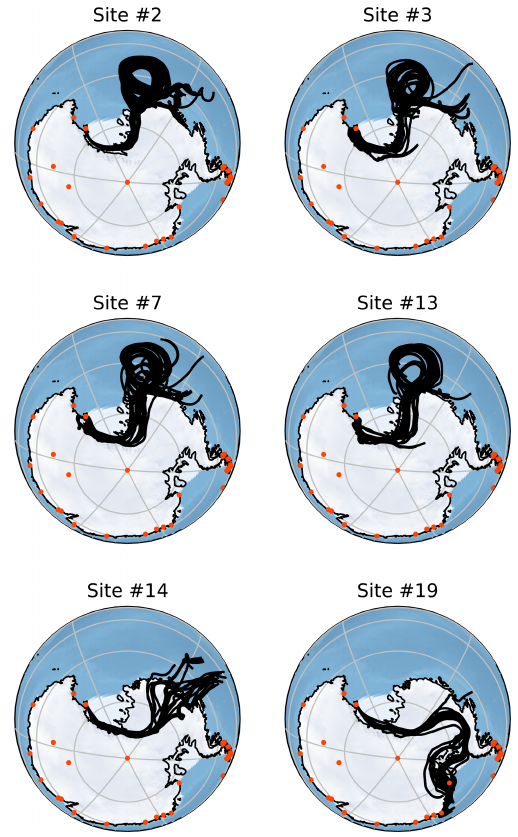
Figure 5. Back-trajectory ensembles generated by HYSPLIT for six of the collected samples. Each of these trajectories is run for 156h with the ensemble members generated by minor perturbations as described in Sect. 2.6. Orange points indicate the locations of active Antarctic research stations that operate all year. All of these trajec- tories are started at 2000m altitude but show very similar results to those started at 500 and 1000m. Note that each simulation is run to correspond to the time of sampling and so is host to different meteorological conditions than other